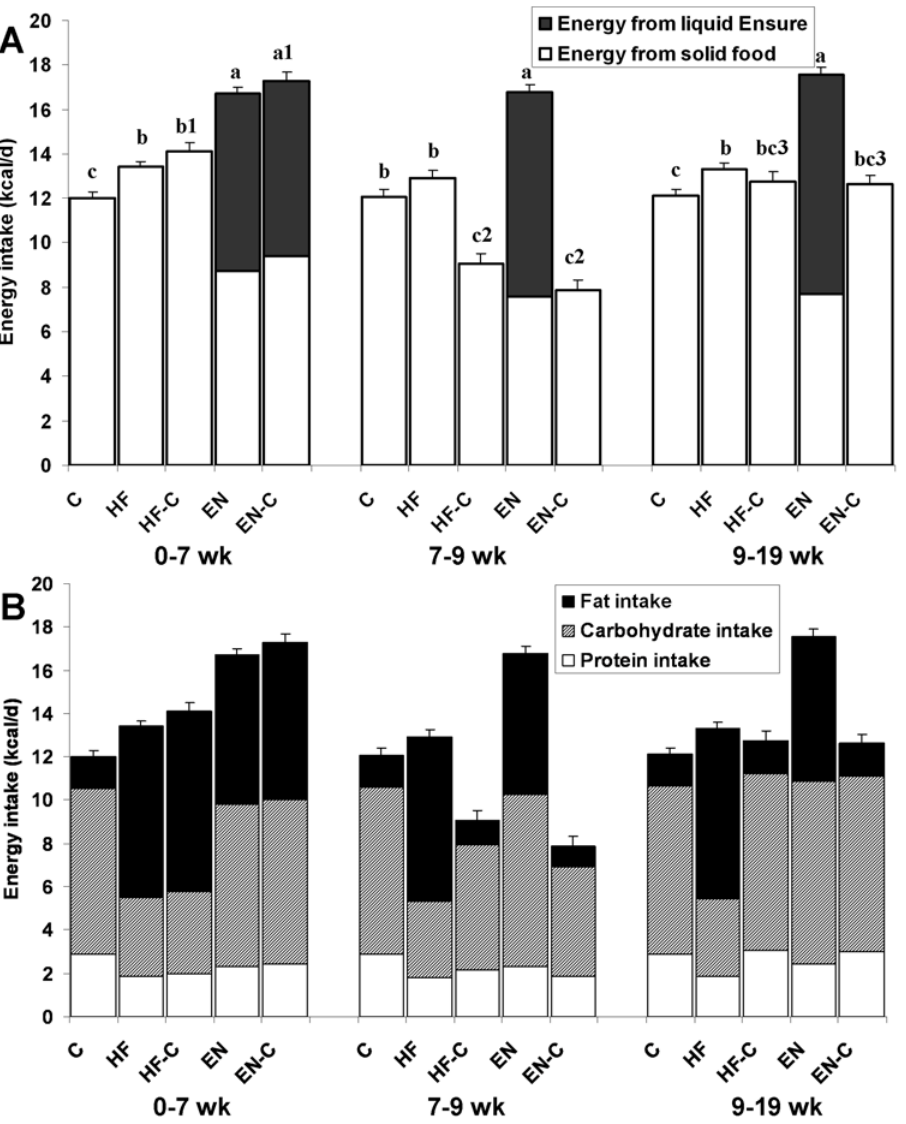
Figure 2. Ad libitum energy intake of male C57BL/6 mice from each diet group. The 5 diet groups: chow diet (C), high fat diet (HF), high fat diet plus Ensure H (EN), high fat diet for 7 wk followed by a switch to chow (HF-C), and high fat diet plus Ensure H for 7 wk followed by a switch to chow (EN-C). Panel A shows the energy intake derived from solid food (open bars) versus liquid Ensure (filled bars). Panel B shows the macronutrient content of the diets indicating the protein intake as open bars, carbohydrate intake as striped bars and fat intake as solid bars. Values are mean 6 SEM. Statistical differences among the means were determined by performing an analysis of variance. Pairwise differences were adjusted for multiple comparisons by Tukey’s method. Different letters indicate significant differences of total energy intake rate across groups within each time period (P , 0.05). Different numbers indicate significant within-group differences of total energy intake rate across the time periods (P , 0.05).